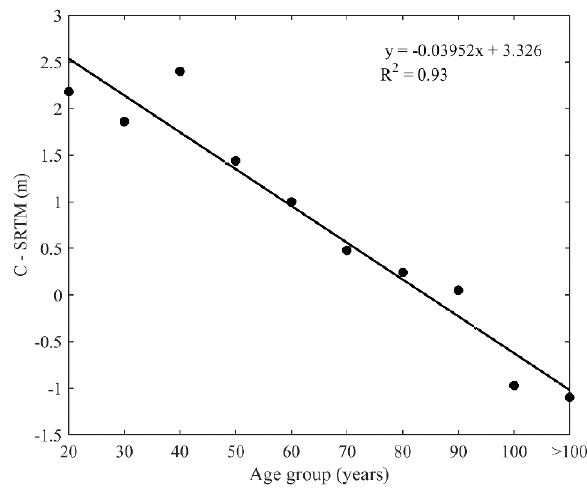
Figure 6 . DEMs difference vs dominant species age groups, including trend